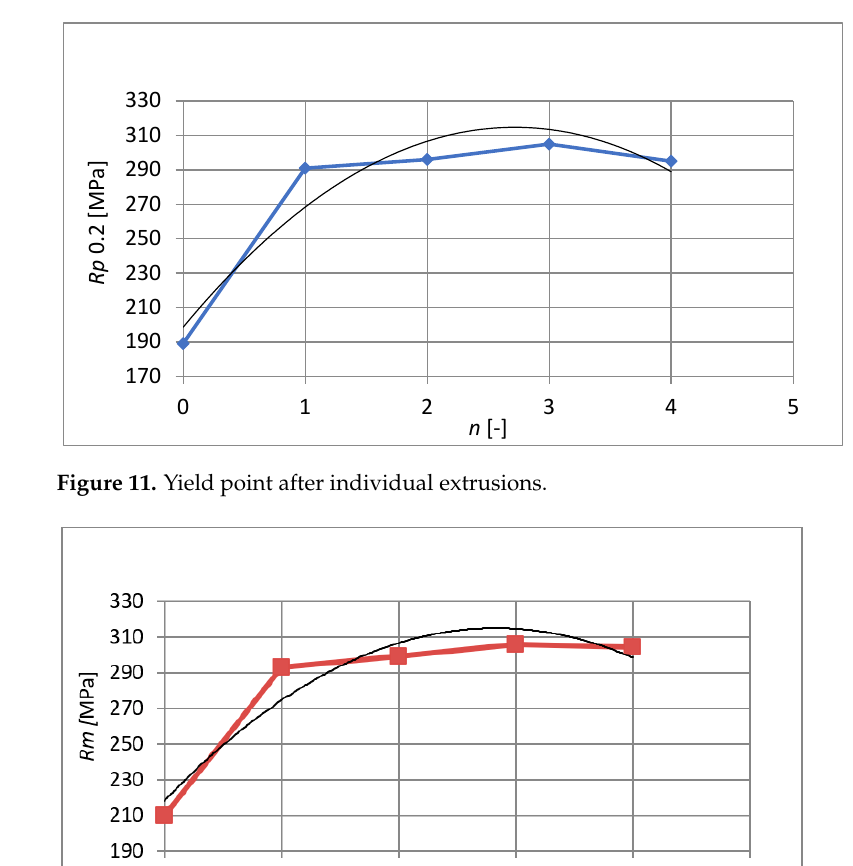
Figure 11. Yield point after individual extrusions.